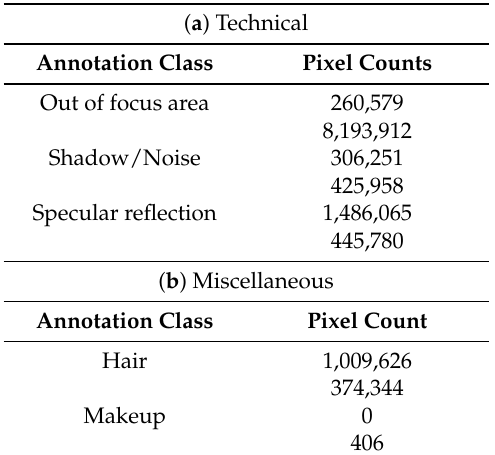
Table 1. Annotation labels and separate pixel counts for spectral data acquired with Nuance EX (top value) and Specim IQ (bottom value) spectral cameras per